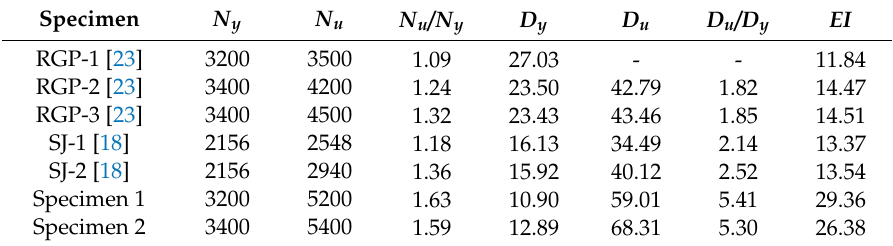
Table 3. Experimental characteristics of the steel–concrete composite joint